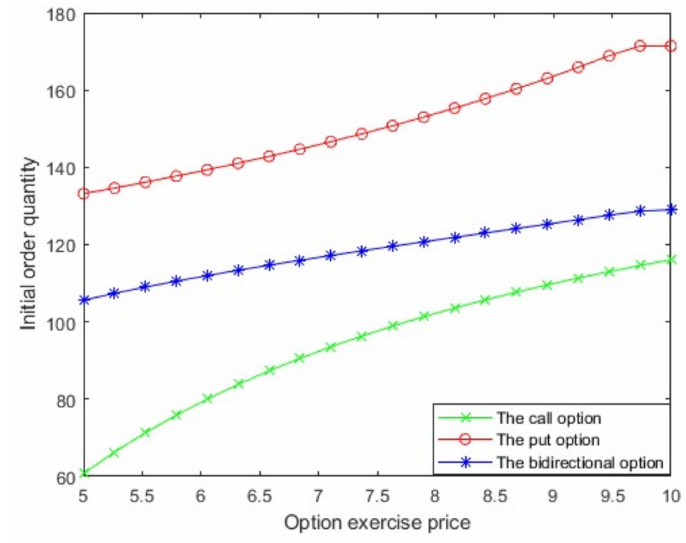
Figure 2. The initial order quantity.